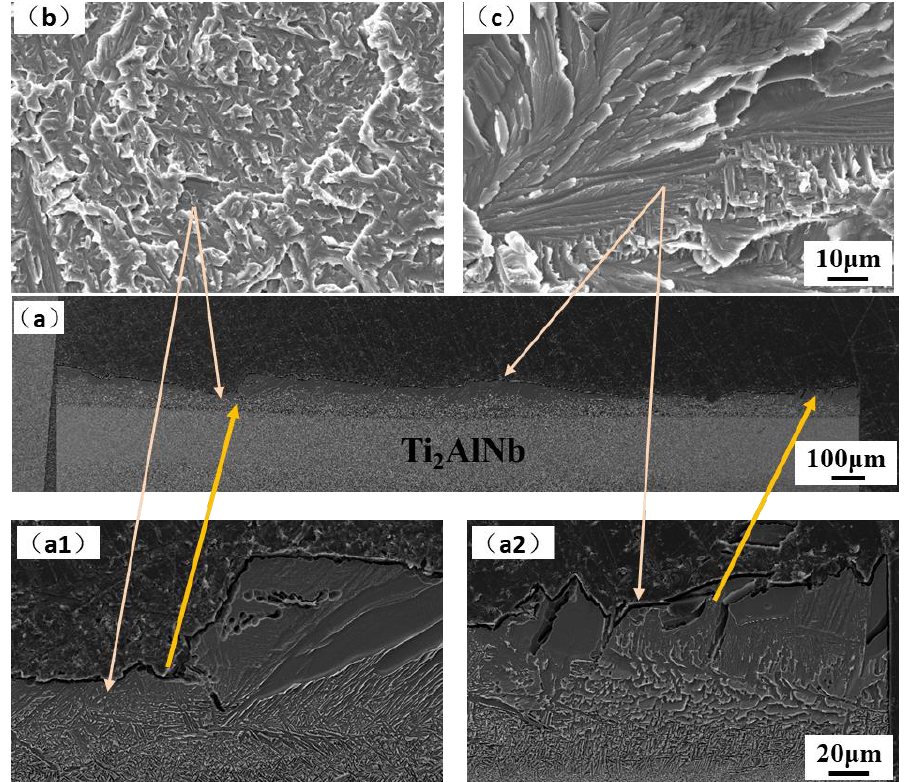
Figure 8. Fracture of room temperature tensile samples: ( a ) cross-section, and ( b , c ) fracture surface. ( a1 ) cross-section near Ti 2 AlNb side ; ( a2 ) cross-section in the interface.